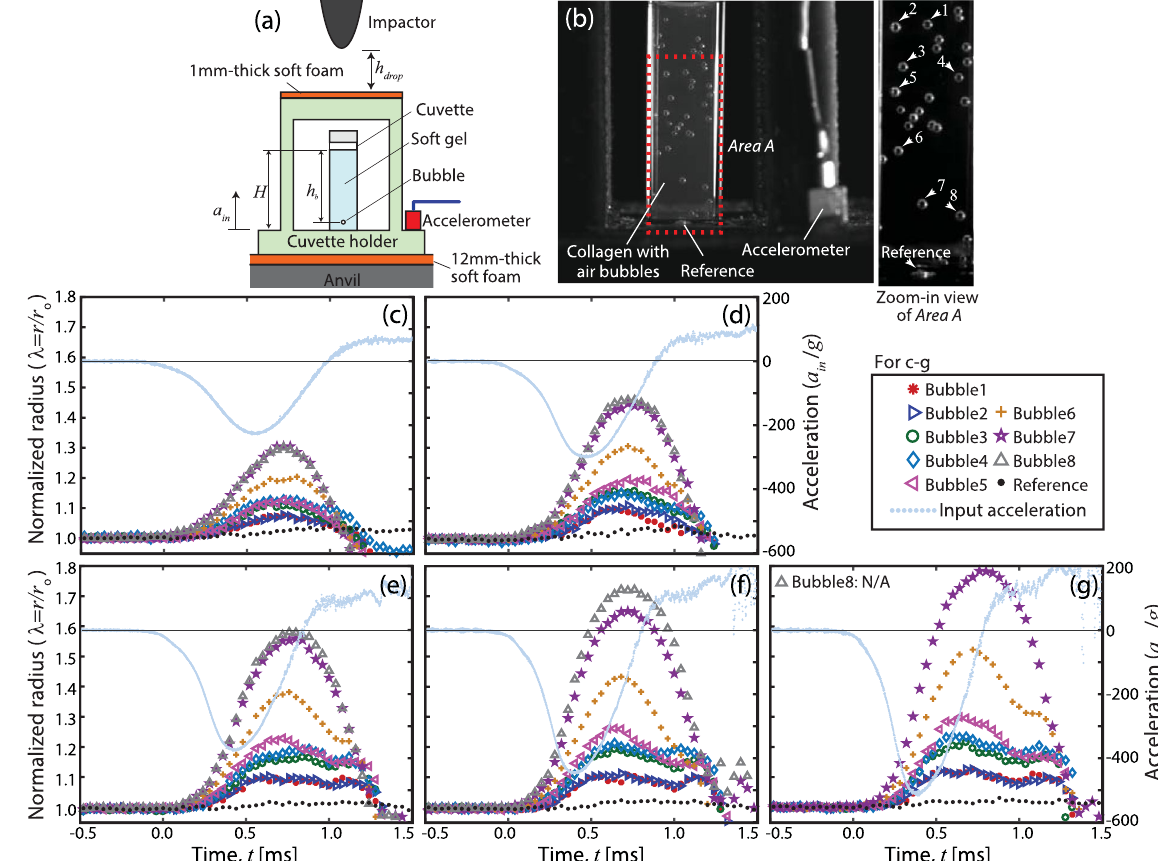
Figure 1. Deformation of air bubbles in a soft gel due to acceleration-induced pressure gradient during mechanical impact. ( a ) shows schematic of a sample holder under a drop-tower system for the characterization of soft material samples in a cuvette where h drop , H , and h b are the drop height, sample height, and bubble location with respect to the gel’s top surface, respectively. Rigid-body acceleration ( a in ) of the cuvette holder was measured by the accelerometer during impact. ( b ) is a high speed camera image of a 1% collagen sample in a transparent cuvette before impact. The zoom-in view of Area A shows eight target air bubbles (1–8) and a rigid plastic inclusion at the bottom of the cuvette ( Reference ). Acceleration signals normalized by gravity ( g ) in c-g (vertical axis on the right) corresponded to 4, 6, 8, 10, and 12 cm drops, respectively. By performing image analysis of high speed image frames in time ( t ), the radii ( r ) of the individual target bubbles indicated by the arrows (1–8 in b ) were monitored. ( c – g ) show the normalized radius ( λ = r / r o ) of the bubbles and reference (vertical axis on the left) due to the impact at t = 0 where r 0 is the initial radius. ( a ) is modified from 15